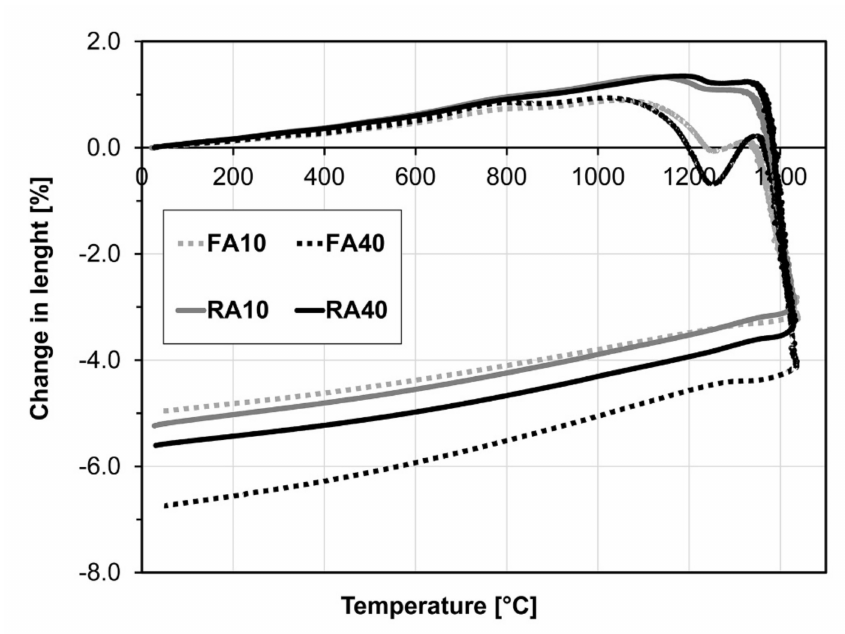
Figure 8. Selected results of the thermal dilatometric analysis.